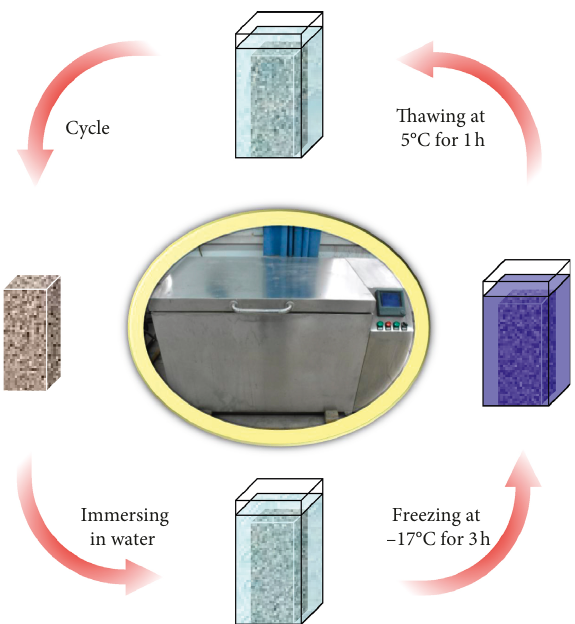
Figure 2: Schematic of the freeze-thaw cycle (FTC)